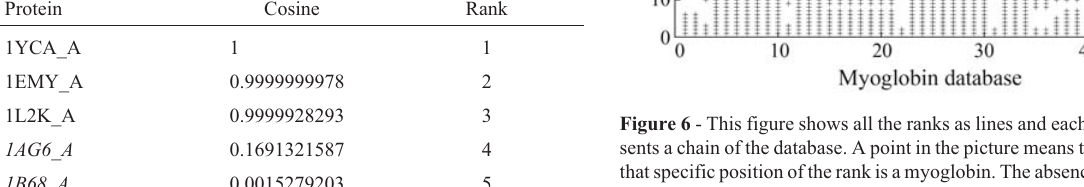
Table 2 - The cosine between the query (1YCA_A) vector and the other proteins.Notehowthecosinebetweenthemyoglobinsisveryhighandthe cosine against the other two proteins is very low. The proteins set in italics are non-myoglobins. Protein